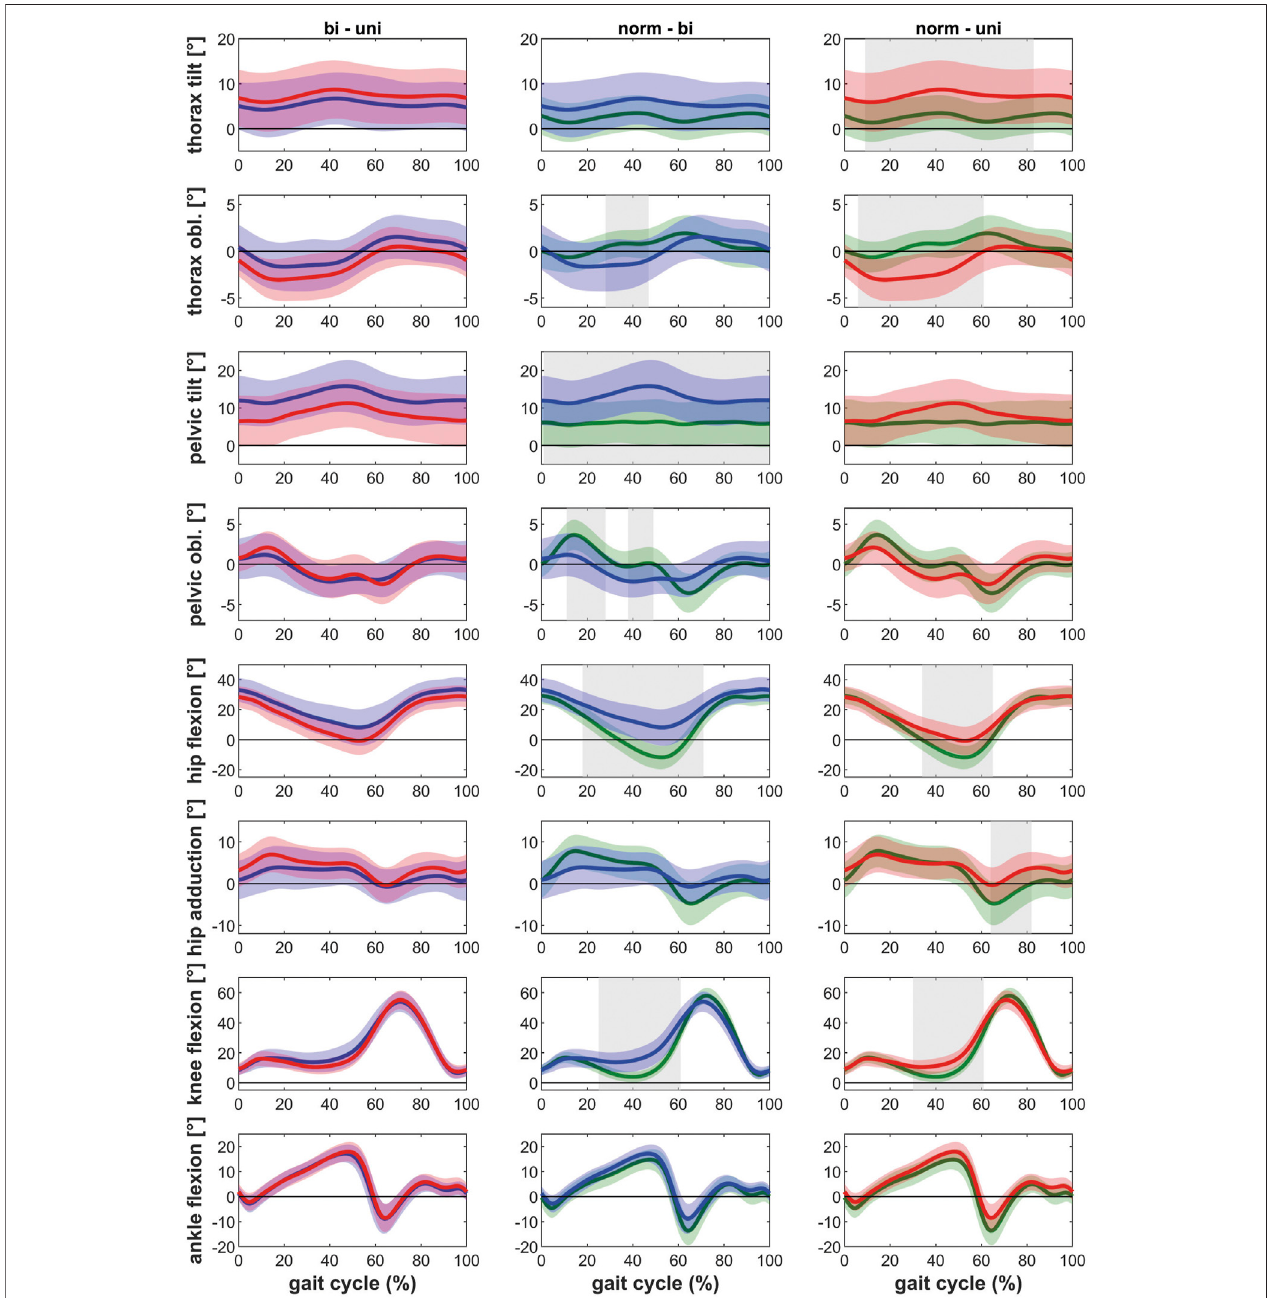
FIGURE 1 | Comparison of the kinematics of the ipsilateral leg between bilateral hip OA patients, unilateral hip OA patients and healthy controls. Mean and one standard deviation of the joint angles. Shaded areas indicate statistical differences. Blue lines (cid:1) bilateral patients, red lines (cid:1) unilateral patients, green lines (cid:1) healthy controls. (A – C) thorax tilt: anterior (+)/posterior ( − ); (D – F) thorax obliquity: towards the contralateral side (+)/towards the ipsilateral side ( − ); (G – I) pelvic tilt: anterior (+)/posterior ( − ); (J – L) pelvic obliquity: up (+)/down ( − ); (M – O) hip fl exion/extension: fl exion (+)/extension ( − ); (P – R) hip adduction/abduction: adduction (+)/abduction ( − ); (S – U) knee fl exion/extension: fl exion (+)/extension ( − ); (V – X) ankle dorsi fl exion/plantar fl exion: dorsi fl exion (+)/plantar fl exion ( −